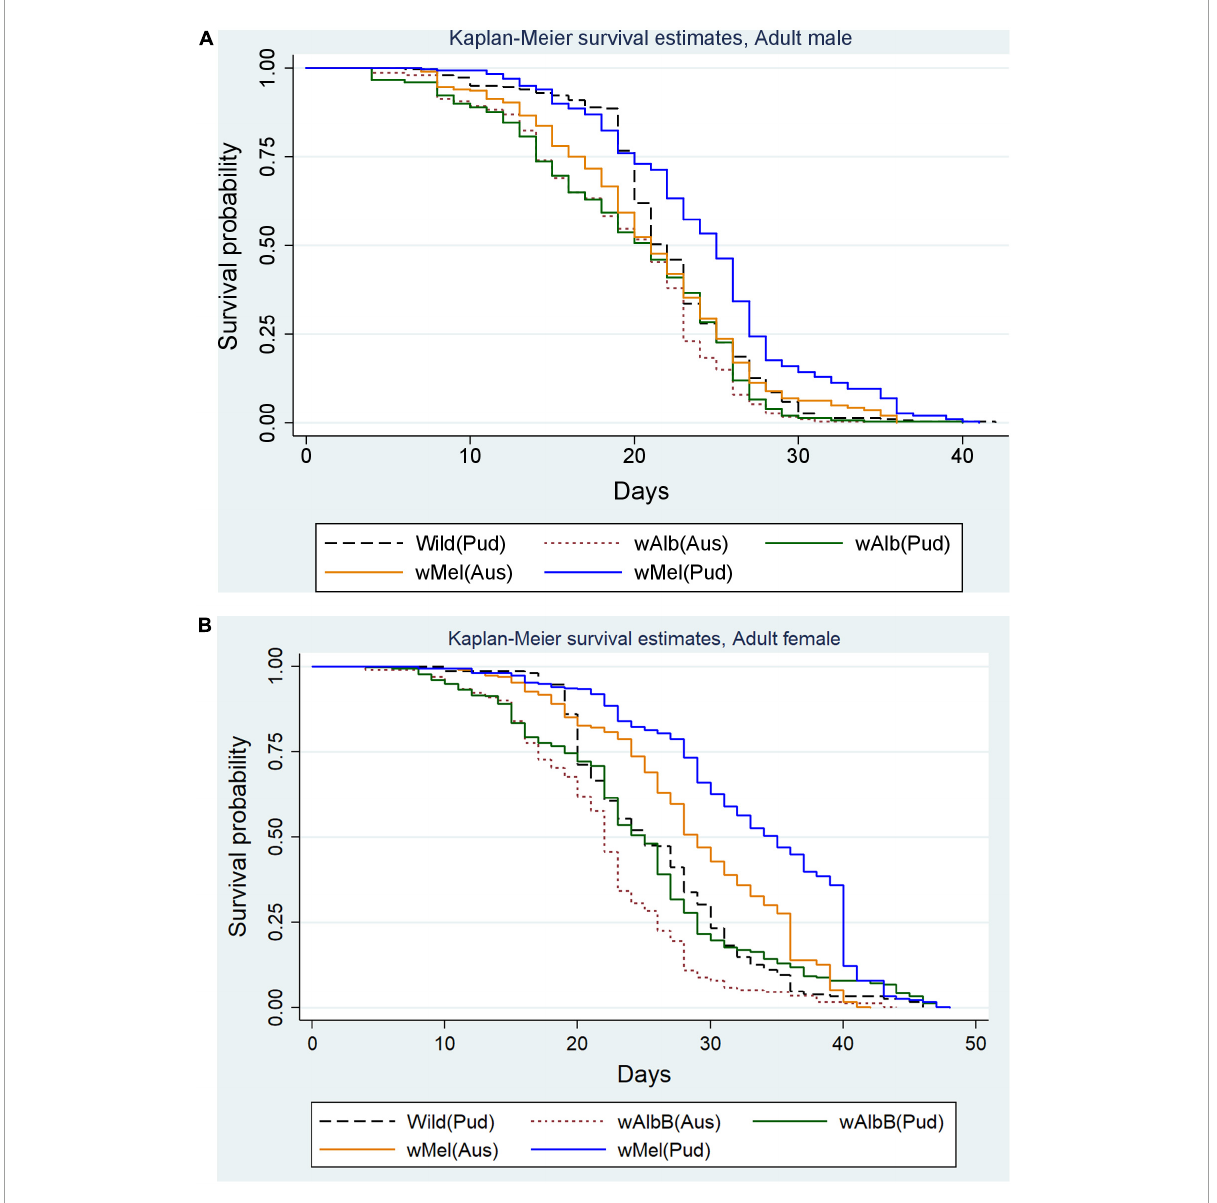
FIGURE3 (A) Survival of Wolbachia- infected Ae. aegypti males in comparison with uninfected wild Ae. aegypti (Pud) males. (B) Survival of Wolbachia -infected Ae. aegypti females in comparison with uninfected wild Ae. aegypti (Pud) females.